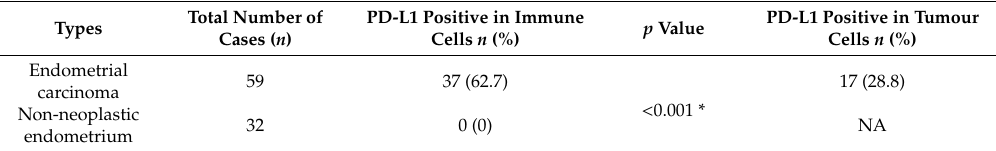
Table 2. Expression of PD-L1 in immune cells and tumour